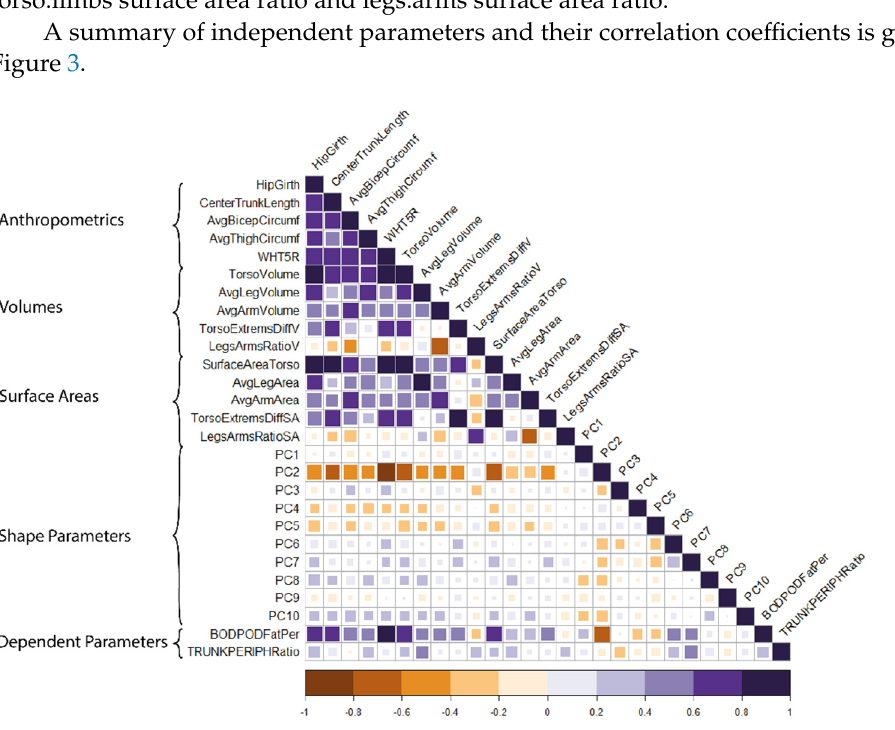
Figure 3. Higher correlations were observed between measures, volumes and surface areas than shape parameters, which were orthogonal by design.